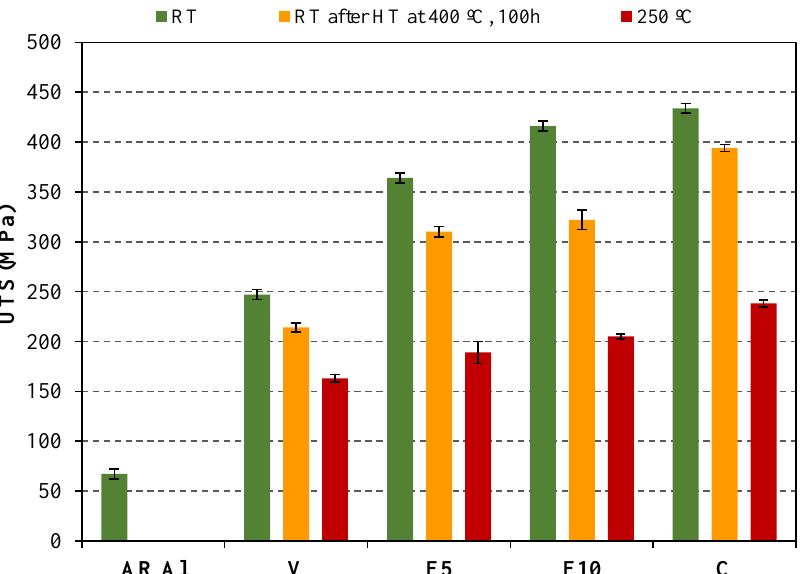
Figure 4. Ultimate tensile strength at room temperature with and without a previous heat treatment (400 °C, 100 h) as well as at high temperature (250 °C).